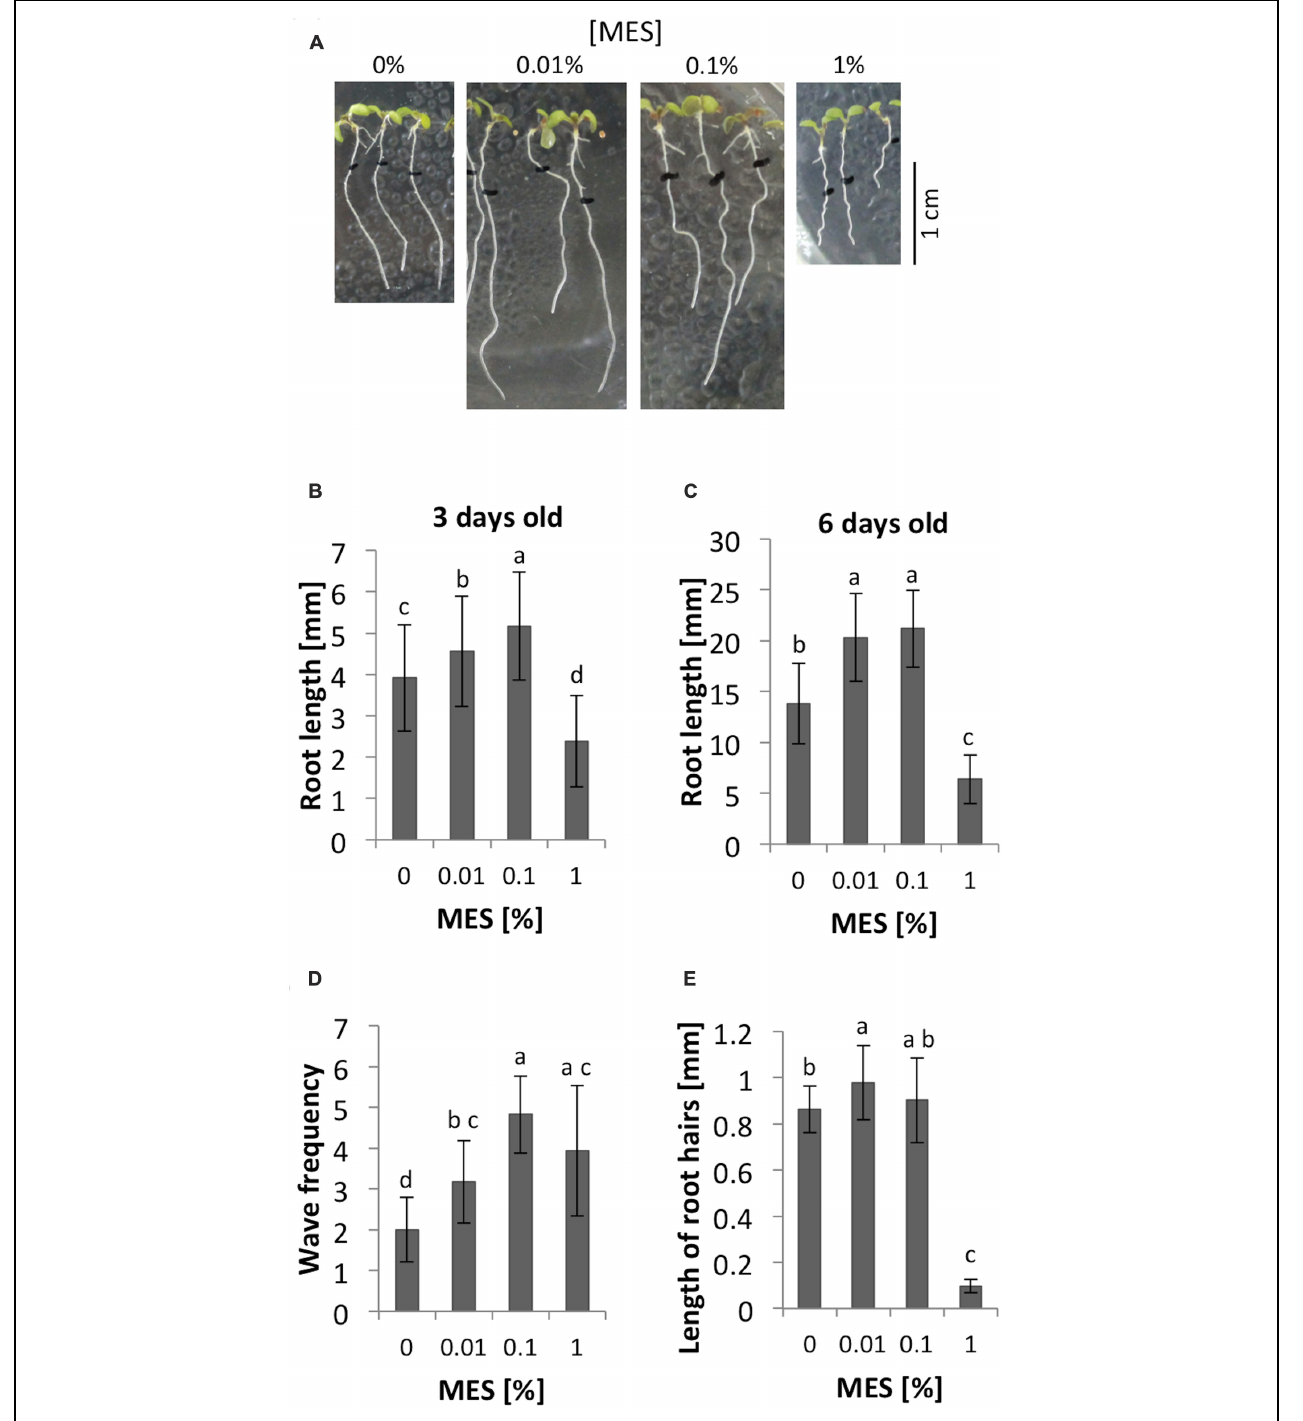
FIGURE 1 | Root growth and morphology in different concentrations of MES. (A) Appearances of seedlings at 6-day old. The seeds were germinated on 1/2 MS medium containing each concentration of MES. Black marks indicate positions of root apices at 3-day old. (B) Root lengths at 3-day after germination on each concentration of MES. Error bars indicate standard deviation of the mean ( n = 62–72). (C) Root lengths at 6-day after germination old on each concentration of MES. Error bars indicate standard deviation of the mean ( n = 34–65). (D) The number of waves of the roots. Error bars indicate standard deviation of the mean ( n = 17). (E) Root hair formation affected by MES. Lengths of root hairs were measured at position where long root hairs emerge, because the distance from the tip varies under different MES treatments. Five root hairs were measured from five seedlings. Error bars indicate standard deviation of the mean ( n = 25). Different letters indicate significant difference (Tukey’s HSD test, P <